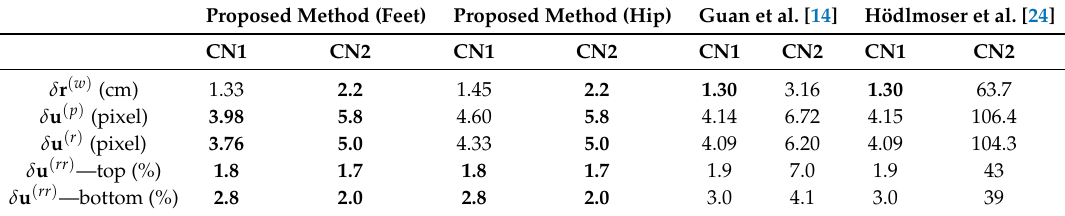
Table 2. Comparison between our method, the method of Guan et al. [14], and the method of Hödlmoser et al. [24] on Camera Network 1 (CN1), Camera Network 2 (CN2). We randomly select 20 locations of the pedestrians in the scene to calibrate the CN1, and CN2. δ r ( w ) , δ u ( p ) , δ u ( r ) , and δ u ( rr ) denotes the triangulation error, projection error, reprojection error, and relative reprojection error, respectively. The bold numbers are the best results among the mentioned